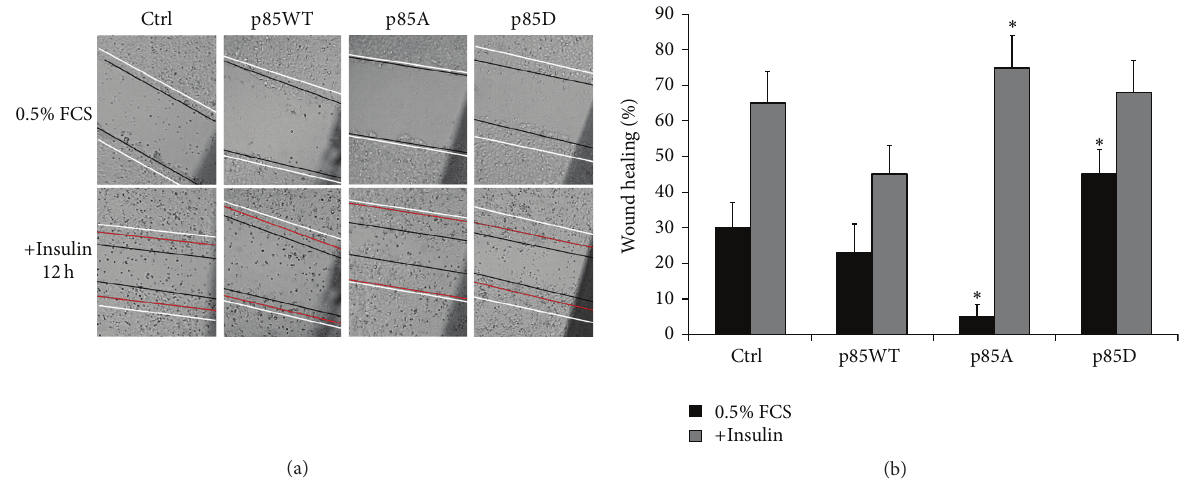
Figure 5: Role of phosphorylation of p 85𝛼 PI 3 K S83 in the control of migratory behaviour. Wound healing assay on MCF-7 cells overexpressing p85WT or mutants untreated or treated with insulin 10 nM for 12h. The white lines indicate the limits of the wound; the black lines indicate the limits after 12 h in the presence of 0.5% FCS or in the presence of 10nM insulin. The red lines in the lower part of the upper panel represent the predicted limits of the wound without insulin. Histogram represents quantification of the insulin treatment effect on cell motility (% of woundhealing)calculatedasratiobetweenthespacedelimitedbythewhitelinesandthosedelimitedbytheblackones;( ∗ 𝑃 < 0.01 comparing versus empty vector). Images are representative of three separate experiments performed in triplicate ( 𝑛 = 9 ). These results were confirmed by a transwell migration assay (data not